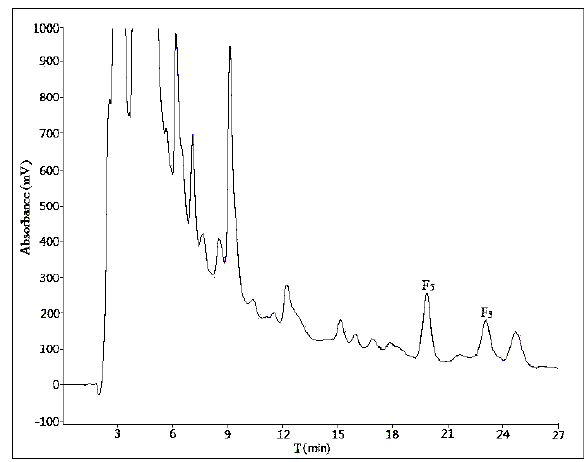
Figure 3. The semi-preparative chromatogram of CEFBPG with the mobile phase of acetonitrile:water (28:72) at room temperature and a flow rate of 10 mL/min.